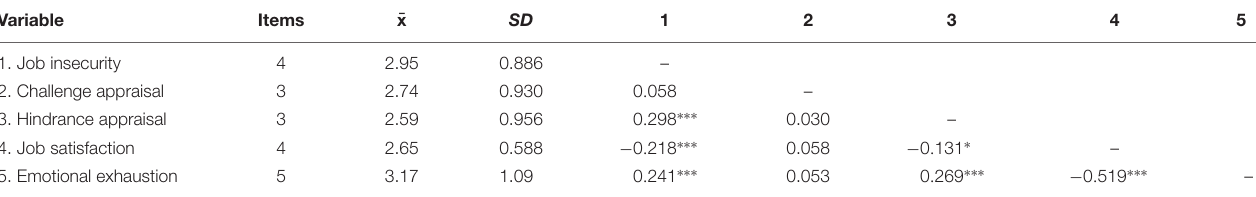
TABLE 2 | Means, standard deviations, and correlations among the variables ( N = 306).